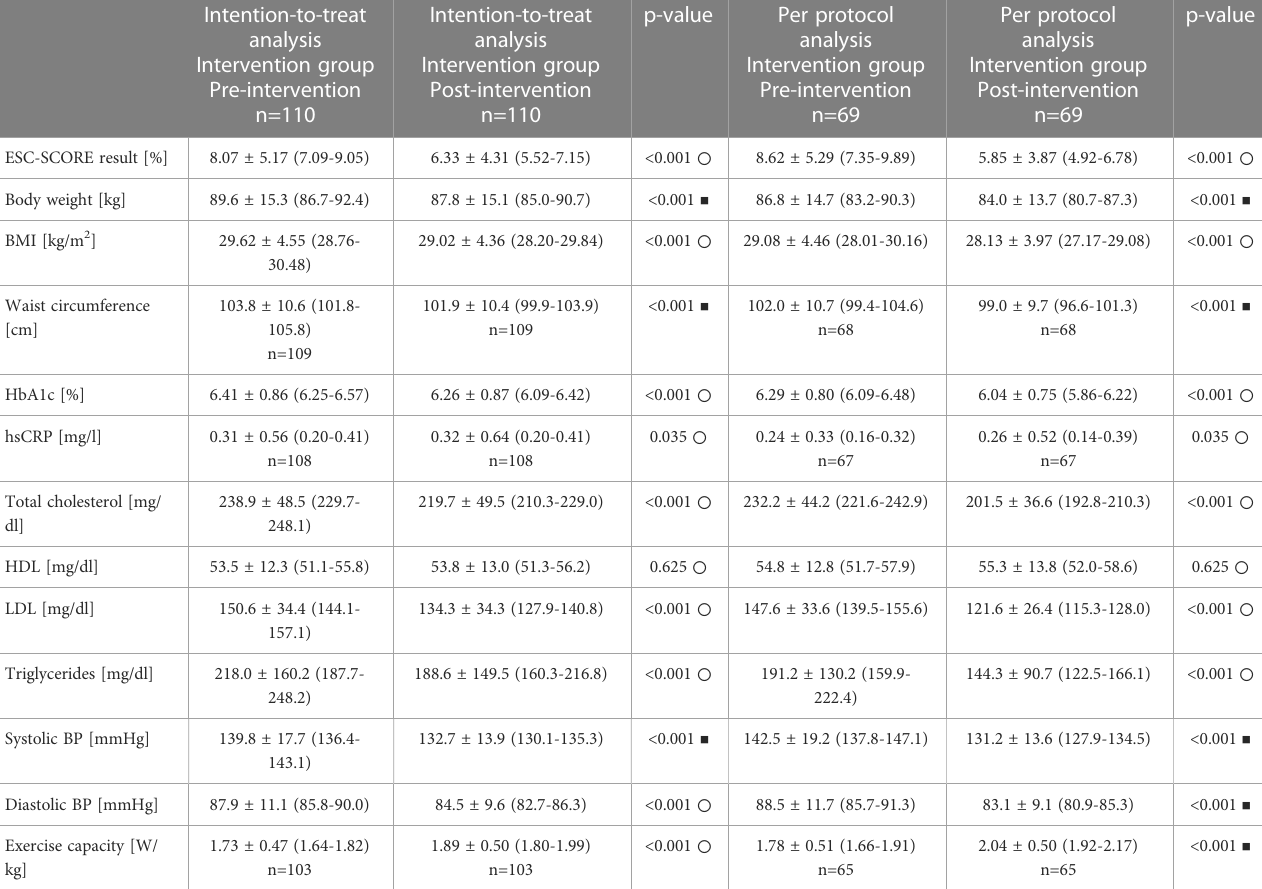
TABLE 3 Study participants´ characteristics pre (T0) and post (T1)